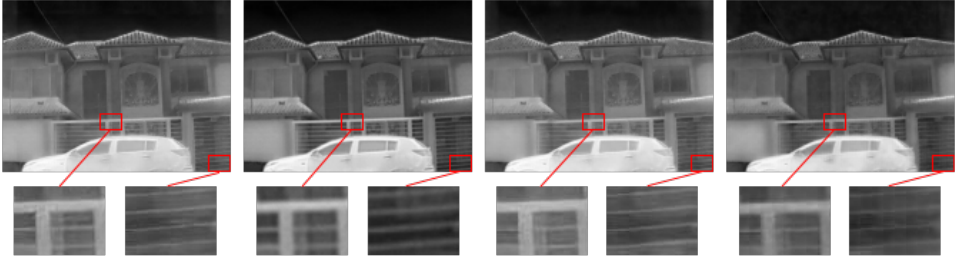
Figure 7. Visual comparison of SR results obtained using work 1 (PA-D1), work 2 (PA-D1-D2), work 3 (PA-D1-AT), and work 4 (PA-D1-D2-AT), respectively.